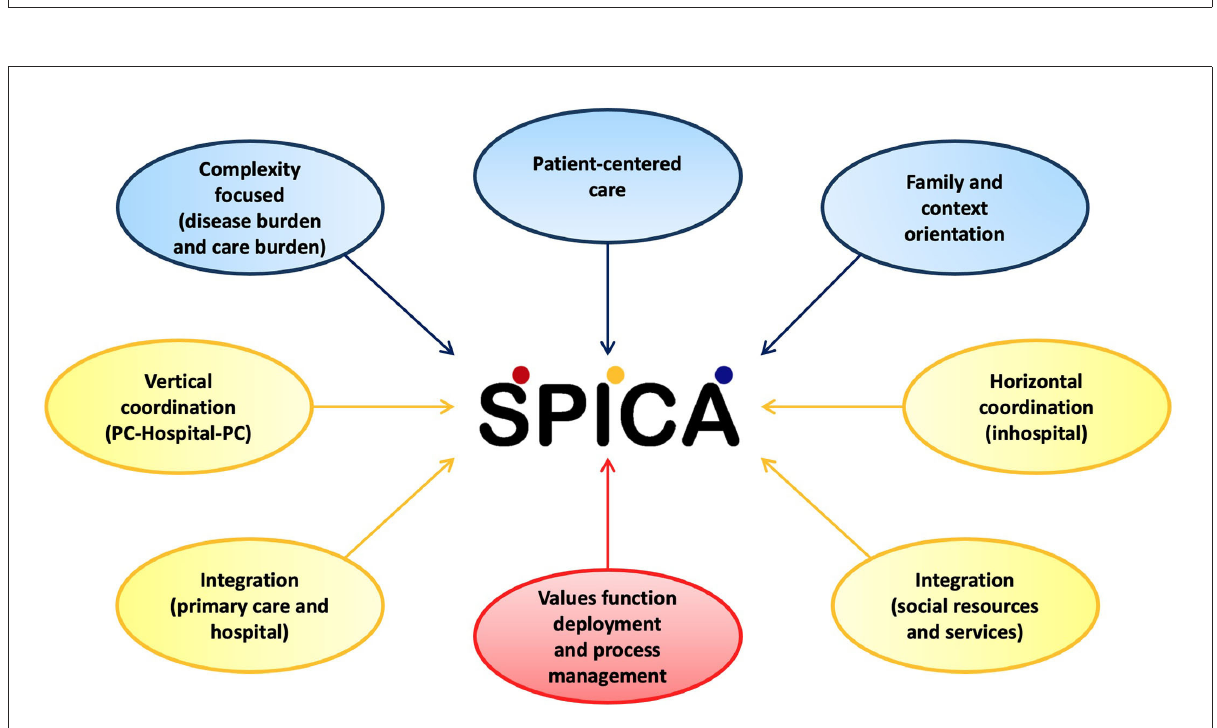
FIGURE3 Major components of the Spica design (PC, primary